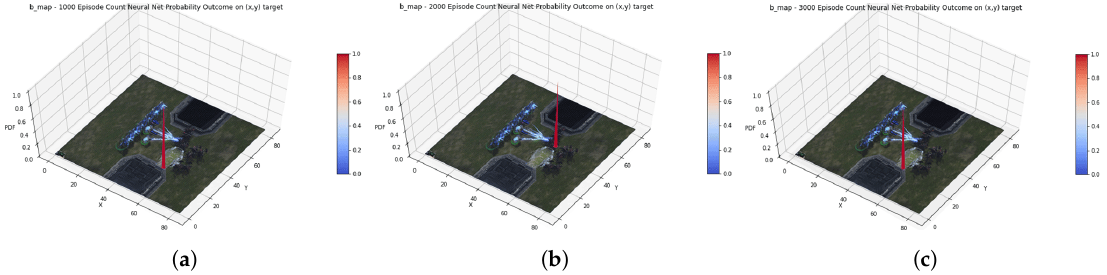
Figure 9. Probability Density Functions (PDF) of global network for ‘( b ) Divide Enemy’ Scenario each describing ( a ) 1000 episodes, ( b ) 2000 episodes, and ( c ) 3000 episodes, respectively.